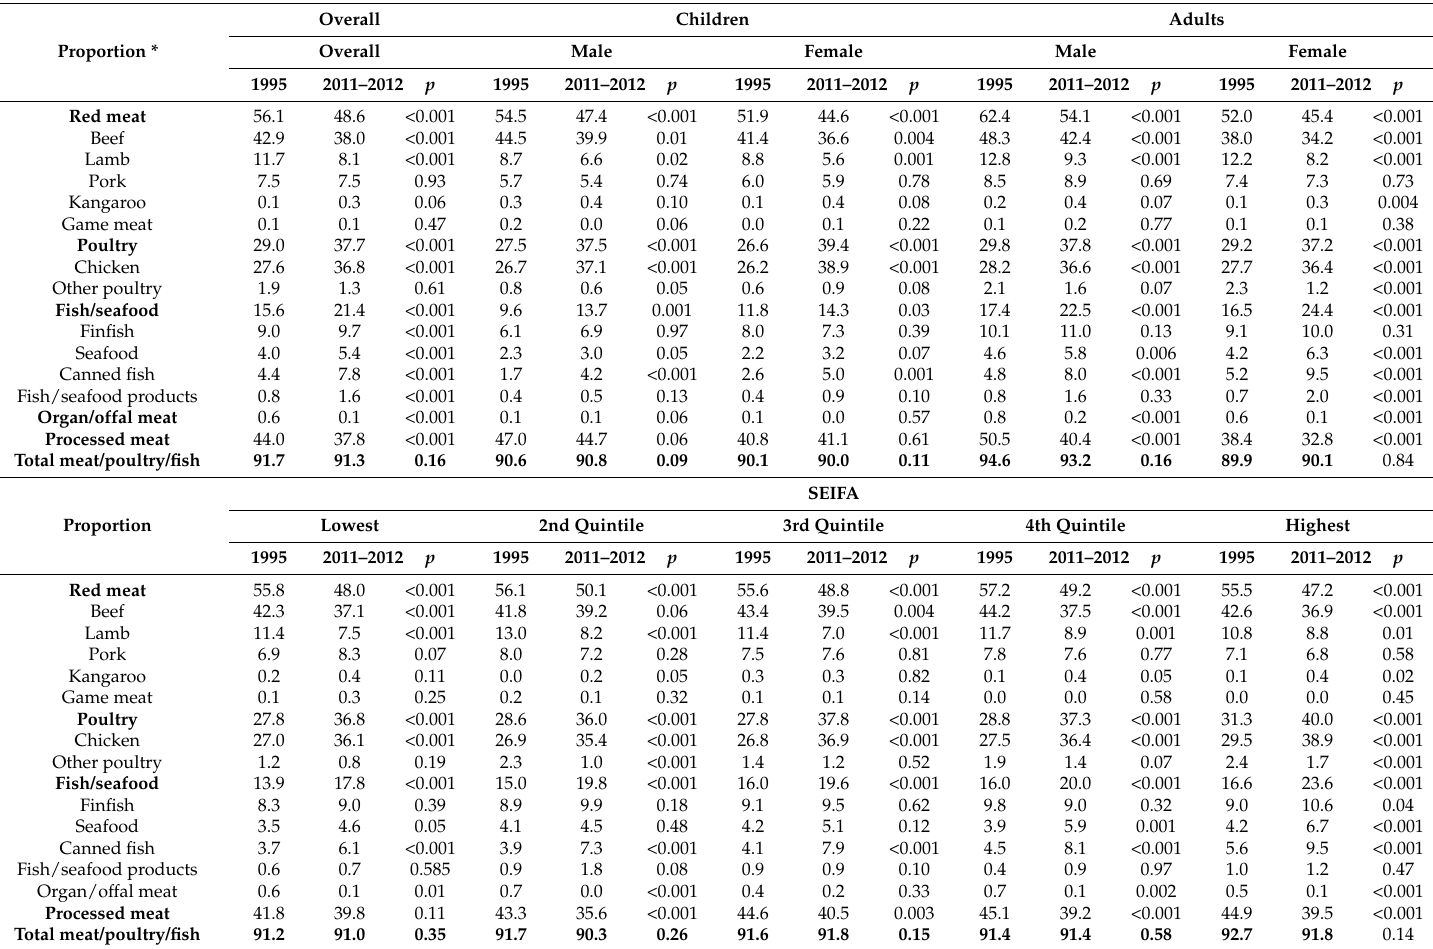
Table 1. Proportion (%) of people consuming meat/poultry/fish from 1995 to